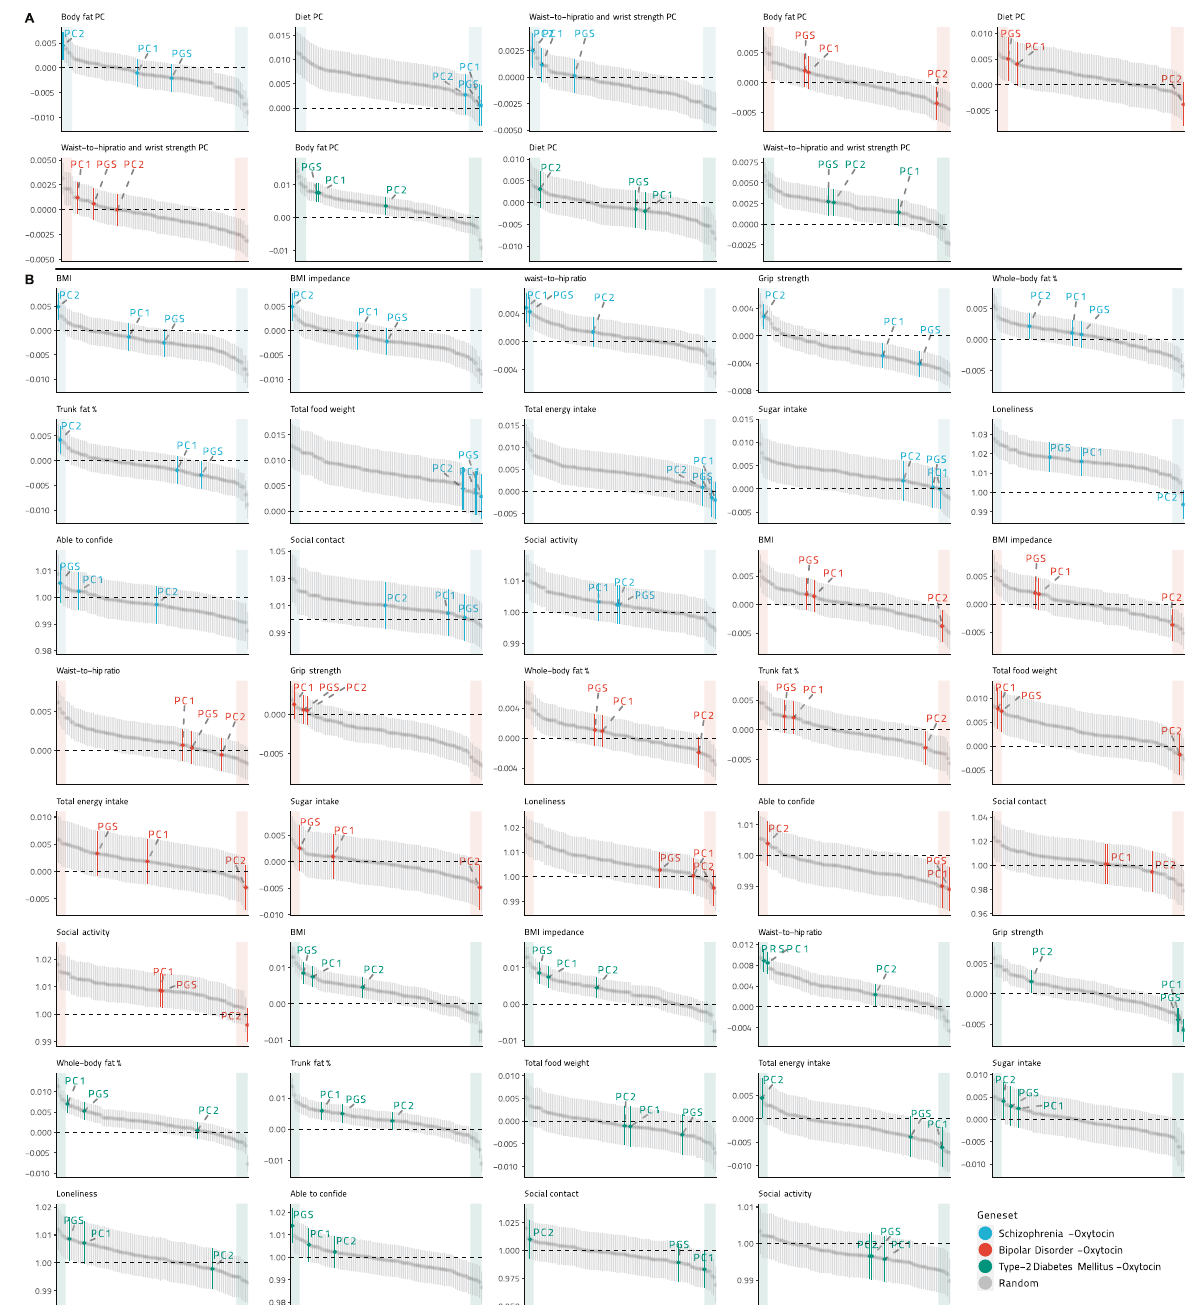
Fig. 2 Distribution plots of the effect sizes of the PGS oxt and PC – PGS oxt models and models from PGSs calculated from 100 random gene sets of equal size for cluster principal components and individual variables. A , B We found that a number of the statistically signi fi cant effects are speci fi c to the oxytocin pathway and not due to the random association of the SNP in the gene set with the chosen phenotype s: schizophrenia, bipolar disorder, and type-2 diabetes mellitus. PGS polygenic score, PC1 fi rst PGS principal component, PC2 second PGS principal